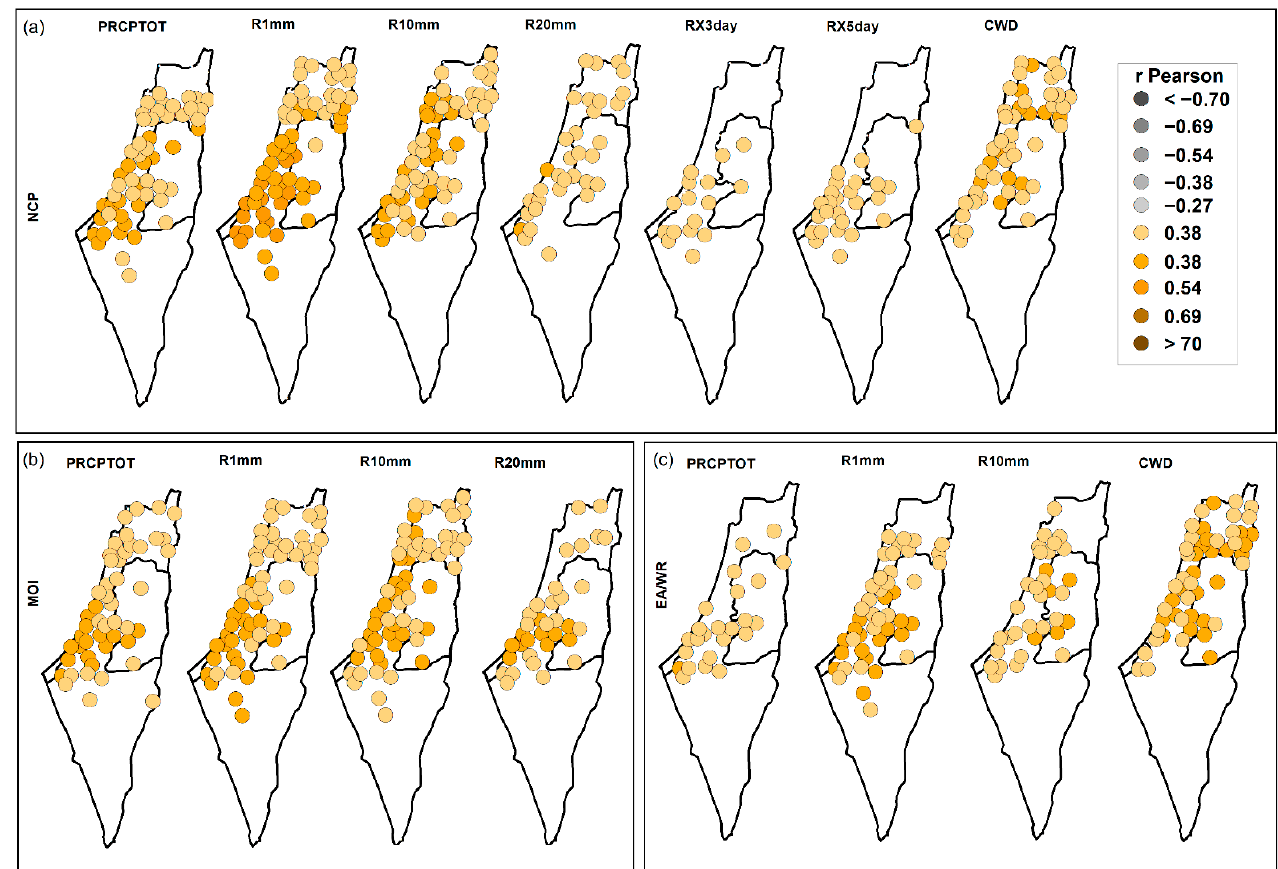
Figure 7. Spatial distribution of significant Pearson correlation coefficients between the teleconnection indices (NCP, MOI and EAWR) and the extreme precipitation indices (PRCPTOT, R1mm, R10mm, R20mm, RX3 day, RX5 day, and CWD), in winter.